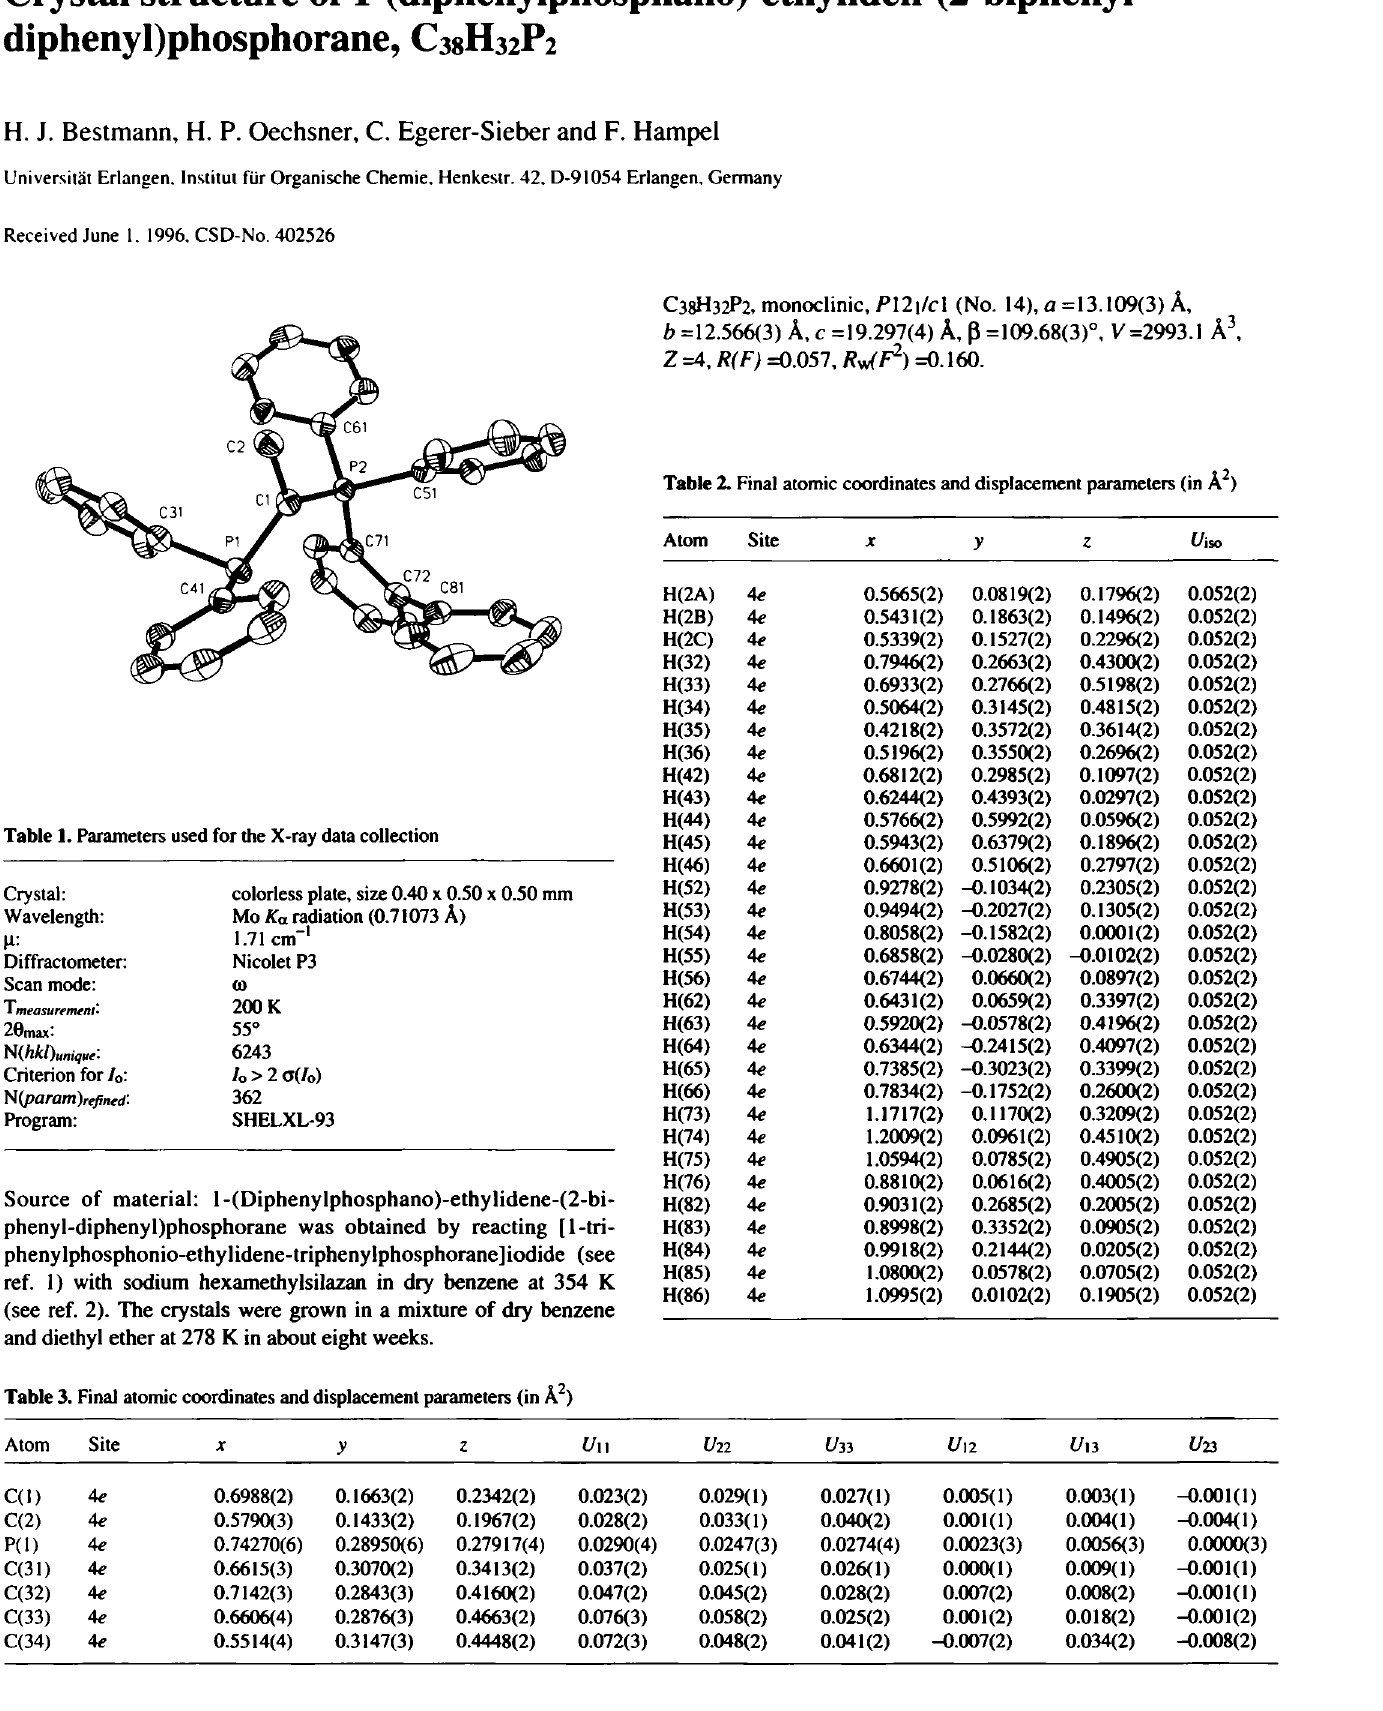
Table 2. Final atomic coordinates and displacement parameters (in A 2